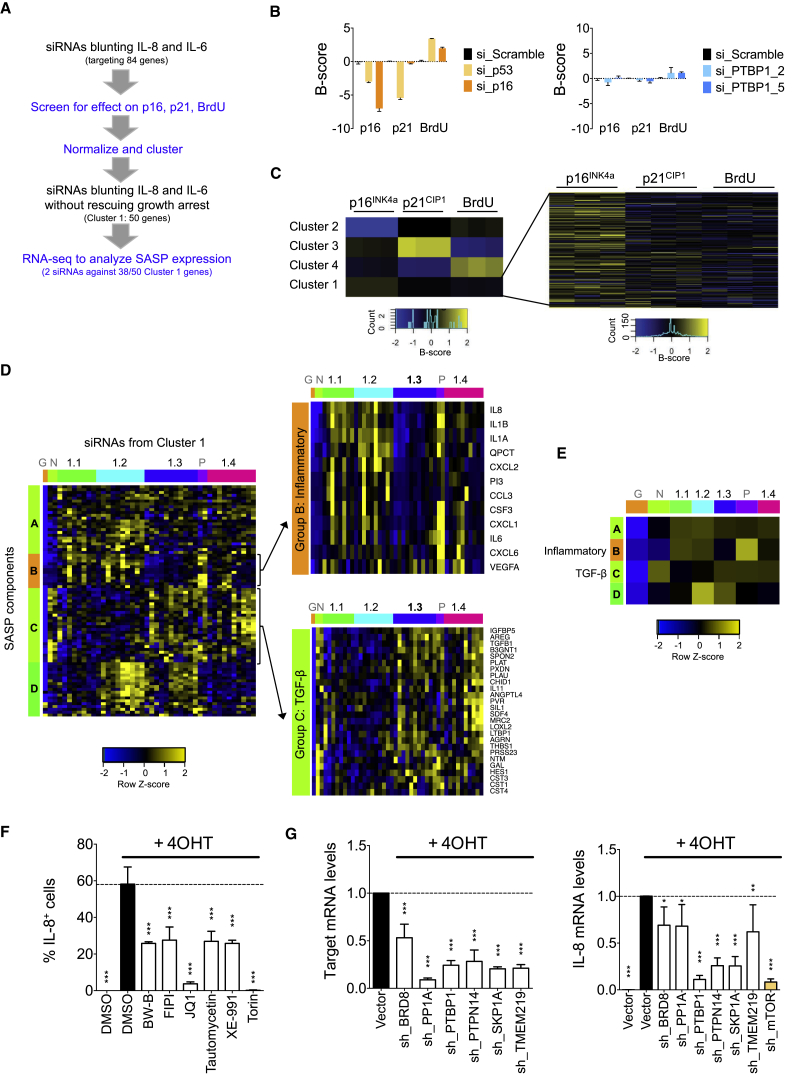
A Subset of Screen Candidates Differentially Regulates the SASP without Affecting the Senescent Growth Arrest(A) Workflow for the categorization of SASP-repressing siRNAs.(B) B scores showing the effects of different siRNAs on the expression of p16 and p21 and incorporation of BrdU. Left: positive controls. Right: two independent siRNAs targeting a gene representative of cluster 1. Data represent mean ± SD (n = 3).(C) K-means clustering of the SASP-repressing siRNAs. Heatmap of cluster 1 showing B-score expression for each replicate experiment (column). Each row reflects the measures from one siRNA.(D) Heatmap showing the differential regulation of SASP components by siRNAs targeting cluster 1 candidates. IMR90 ER:RAS cells were independently transfected with two siRNAs targeting 38 of the cluster 1 candidates. RNA-seq was performed and samples clustered according to the expression of SASP components. G: growing cells including cells transfected with scramble siRNA but not treated with 4OHT (no SASP induction), N: grouping senescent cells transfected with siRNAs targeting CEBPβ and RELA (preventing the induction of many SASP components), Pos: cluster grouping senescent cells transfected with scramble siRNA or a siRNA targeting p16 (showing a “maximum” SASP induction). Each column represents an average of two siRNAs per gene with three replicates each. Left: hierarchical cluster showing the siRNA subclusters (colored horizontally) and the clustering of SASP components in groups (colored vertically). Right: zoom-in showing the effect of siRNAs on indicated SASP groups.(E) Summary heatmap derived by averaging the heatmap presented in (D) showing differential regulation of SASP components.(F) IL-8 IF analysis 8 days after senescence induction of IMR90 ER:RAS cells treated with indicated drugs targeting cluster 1 genes. Torin 1 was included as control. Data represent mean ± SD (n = 3); ∗∗∗p < 0.001. Comparisons with DMSO + 4OHT.(G) Expression levels of each gene or IL-8 measured by qRT-PCR 6 days after 4OHT induction of IMR90 ER:RAS cells stably infected with an empty pGIPZ vector (Vector) or pools of four pGIPZ-based shRNAs against the indicated candidate SASP regulators. An shRNA targeting mTOR (sh_mTOR) was included as control. Data represent mean ± SD (n = 3); ∗p < 0.05, ∗∗p < 0.01, ∗∗∗p < 0.001. Comparisons with Vector + 4OHT.One-way ANOVA (Bonferroni’s test) was used in (F) and (G) to calculate statistical significance. See also Figure S2 and Table S1.